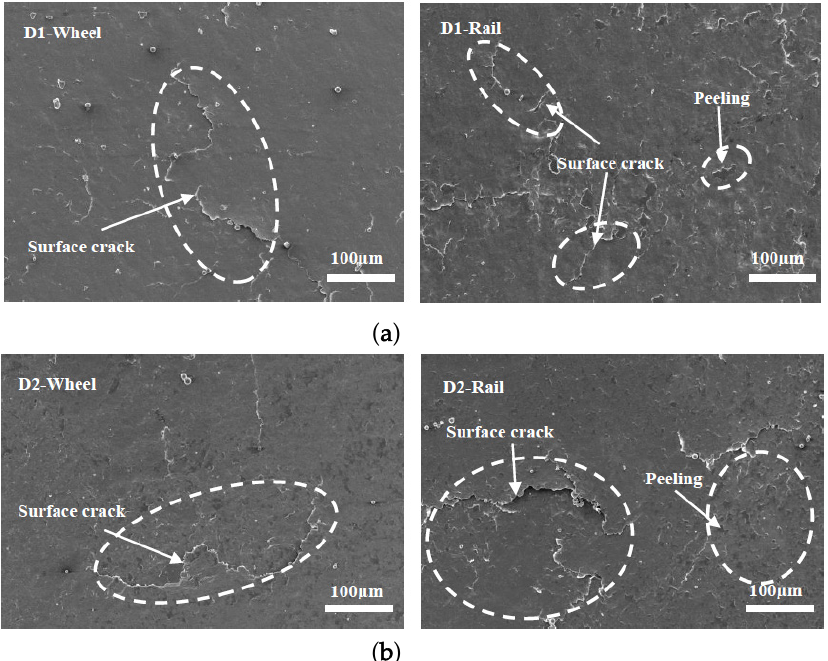
Figure 12. Micrographs of the worn surfaces of the wheel and rail rollers at 50 °C. (a) D1; (b) D2.